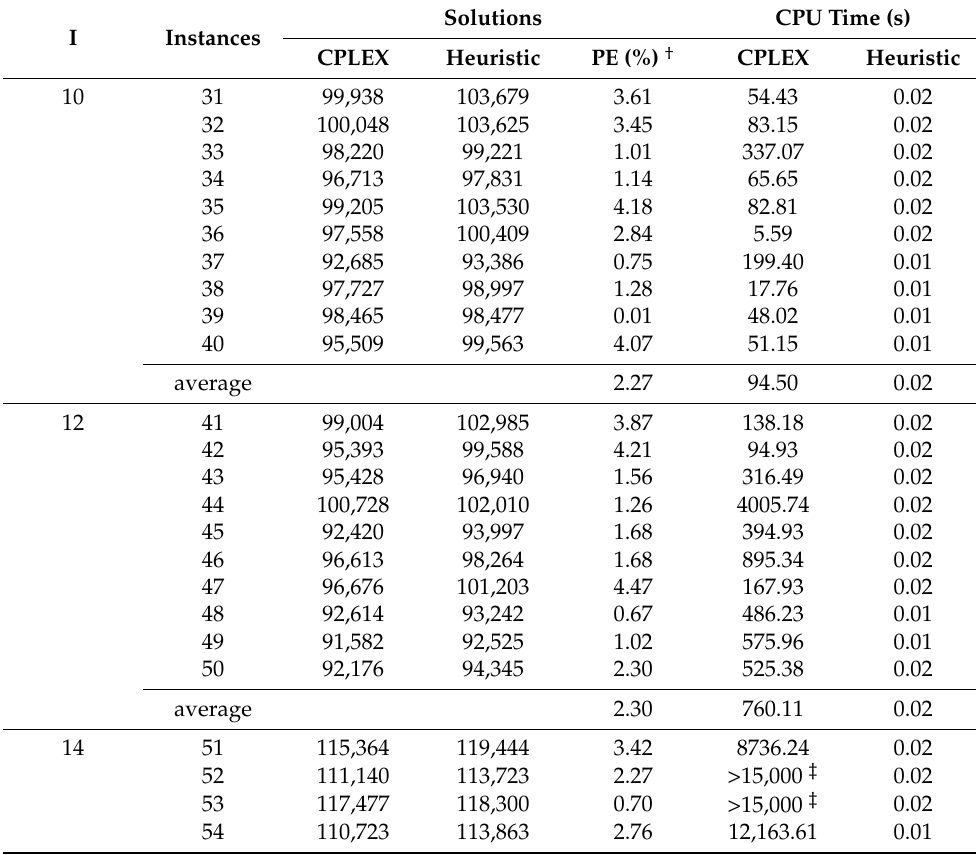
Table 2. Results of the test on 8-period